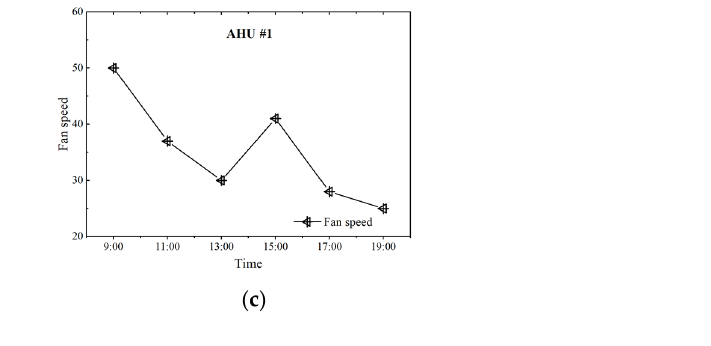
Figure 16. Experimental operation data curve. ( a ) Temperature and air volume of rooms #2, #3, and #4. ( b ) The damper openings of the VAV boxes in rooms # 2, #3, and #4. ( c ) Fan speed of AHU in room # 1.